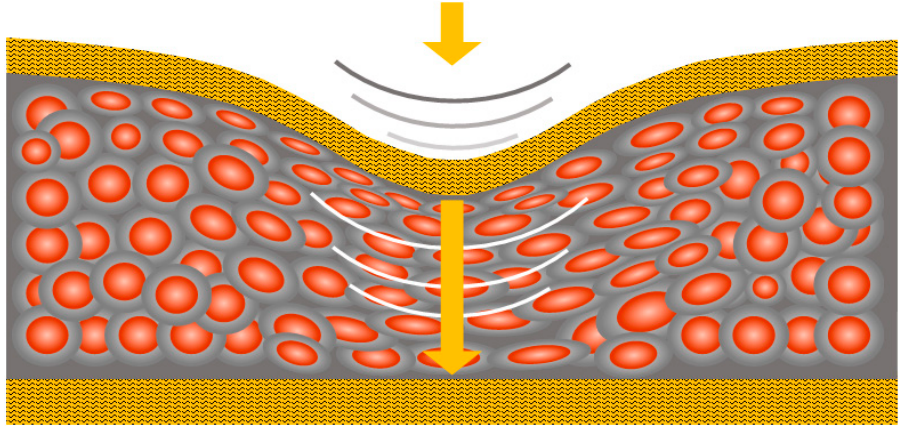
Figure 3. Conduction occurs ‘through’ the materials only at the point of applied pressure or stimu- lus.